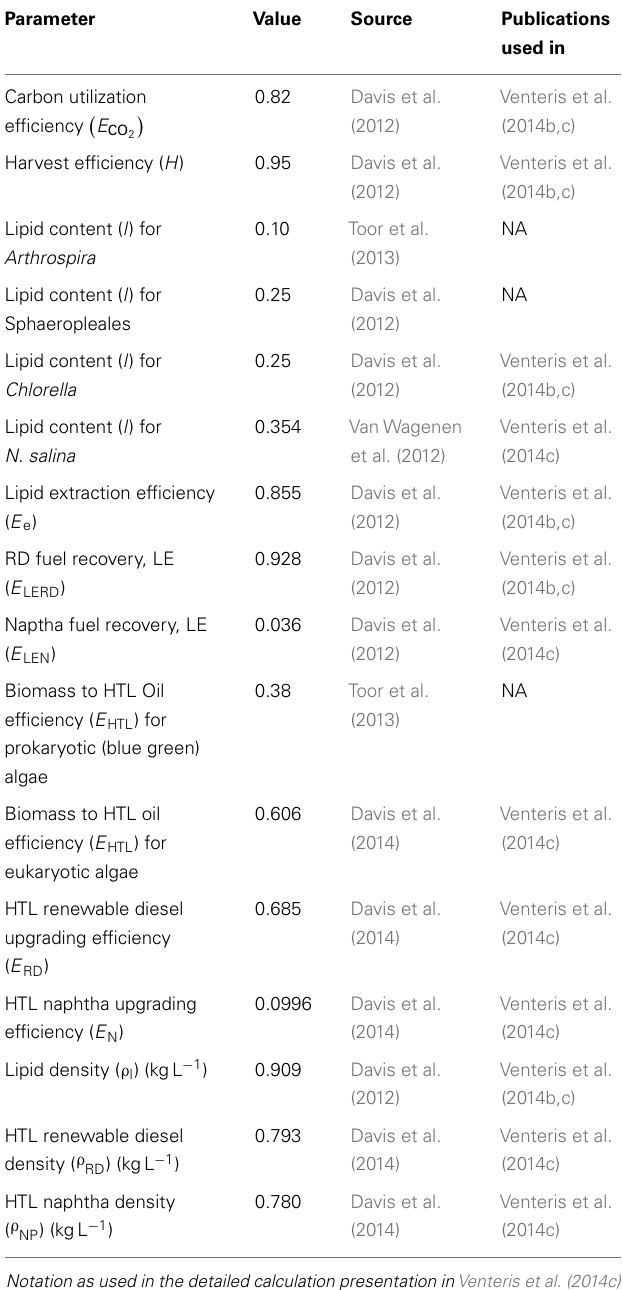
Table 2 | Summary of parameters used in CO 2 demand and biomass to biofuel calculations